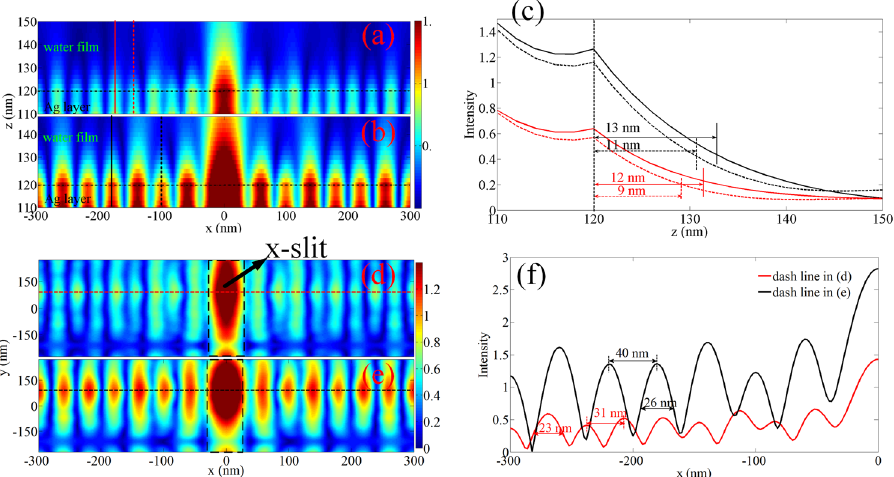
Figure 2. The distribution of the SW-SPs in the water film of the MSS. ( a ) and ( b ) The distribution of x - component of the electric field in y = 0 plane, when the dielectric materials in Layer C is Al 2 O 3 and SiO 2 , respectively. ( c ) The intensity of the electric field along the vertical lines in ( a ) and ( b ): red for ( a ) and black for ( b ). ( d ) and ( e ) the distribution of x -component of the electric field in z = 122 nm plane, when the dielectric materials in Layer C is Al 2 O 3 and SiO 2 , respectively. ( f ) The distribution of the electrical field intensity along the dashed lines, red for ( d ) and black for ( e ),